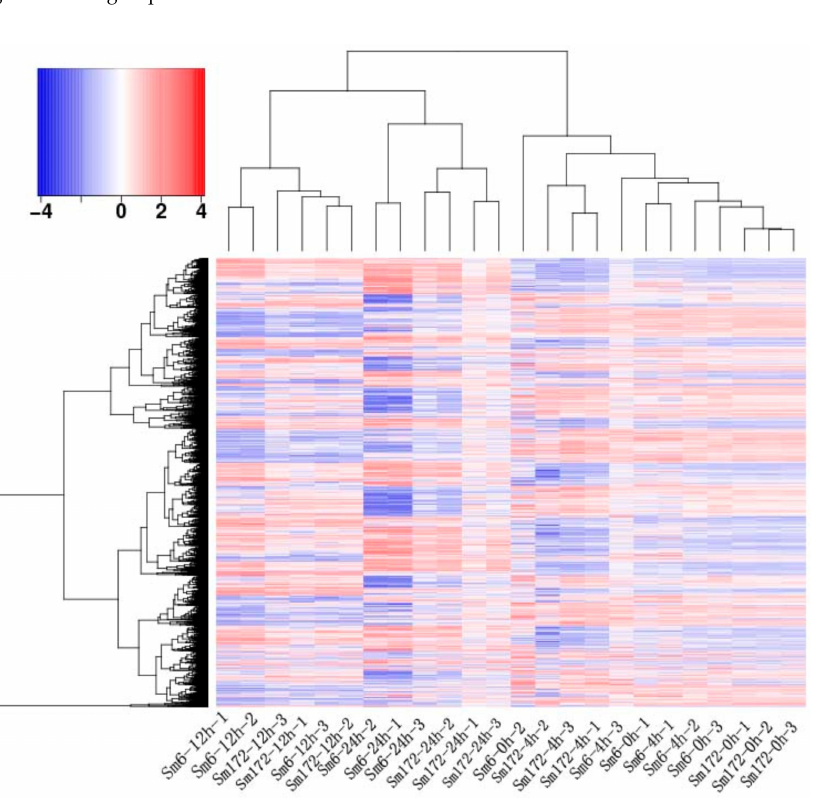
Figure 1. Cluster map of